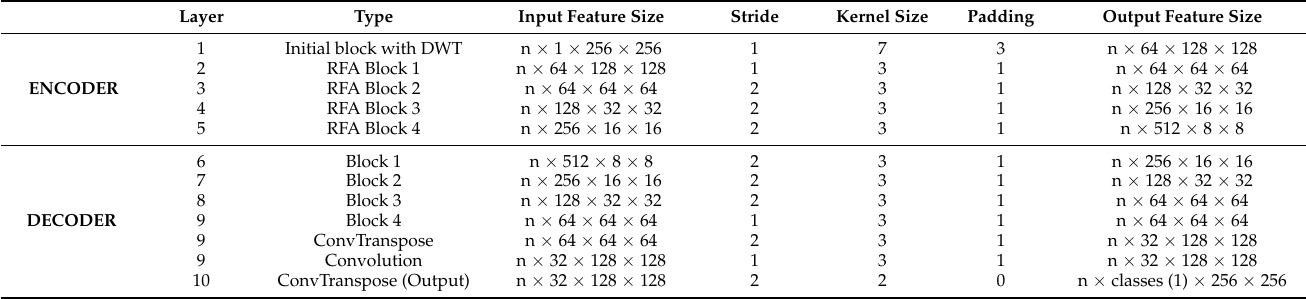
Table 1. Architecture details of LungINFseg. Skip connection is used to connects the encoder layers with the corresponding decoder layers to preserve the spatial